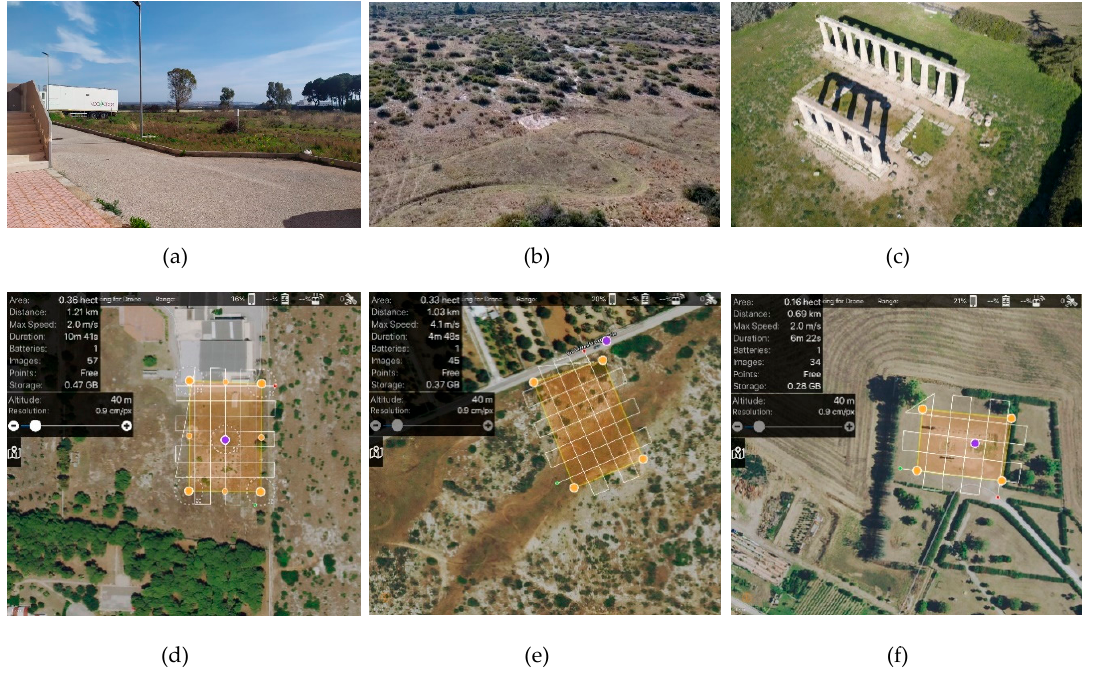
Figure 2. Test sites under investigation: panorama image of the test site 1 ( a ), test site 2 ( b ) and test site 3 ( c ) flight planning on test site 1 ( d ), on test site 2 ( e ) and on test site 3 ( f ).